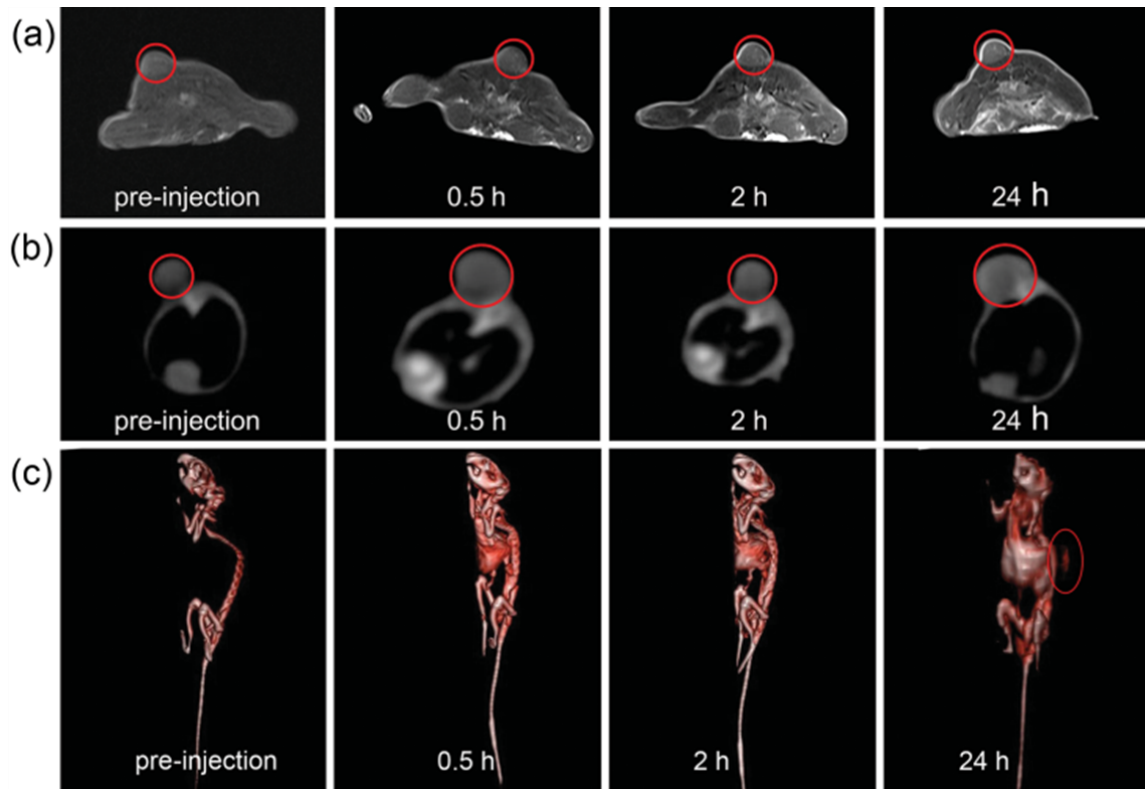
Figure 10: In vivo a) MR and b) CT images c) 3D volume rendering CT images of nude mice after intravenous injection of UCNP@PDA 5 -PEG at different timed intervals (pre-injection, 0.5, 2, and 24 h post-injection), respectively. The tumor site was marked by red circle